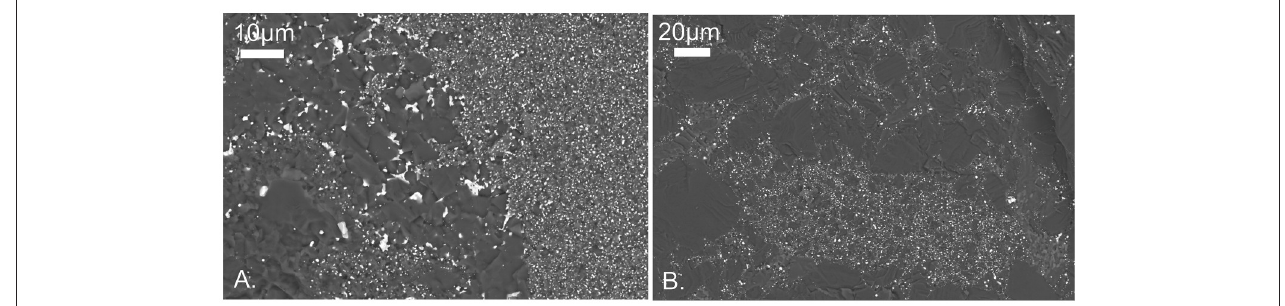
FIGURE 11 | The effect of grain size on melt fraction and distribution. BSE images showing distribution of Au melt in Al 2 O 3 (A) and MgO (B) . In both materials, melt is confined to grain boundary regions, and has largely drained away to leave disconnected melt. In coarser matrices, melt blobs are larger and better defined. In adjacent regions of the same sample, melt is sometimes at high enough fractions to form interconnected channels. In fine-grained (submicron) regions, melt fraction appears higher, presumably due to higher volume fraction of grain boundaries, although trapped melt is only present as submicron, spherical blobs, and no melt channels